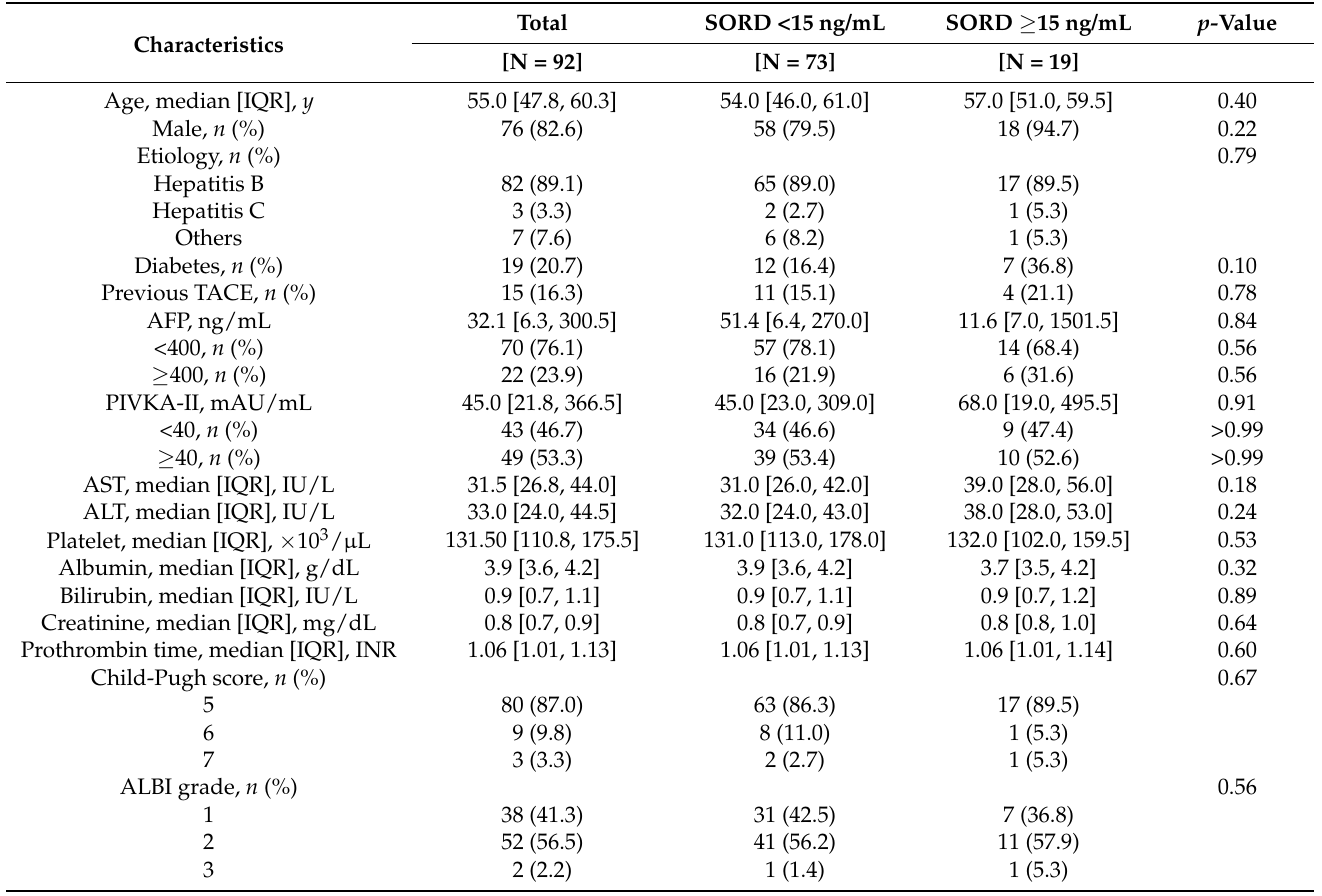
Figure 1. Patient flow chart. Table 1. Study population baseline characteristics.